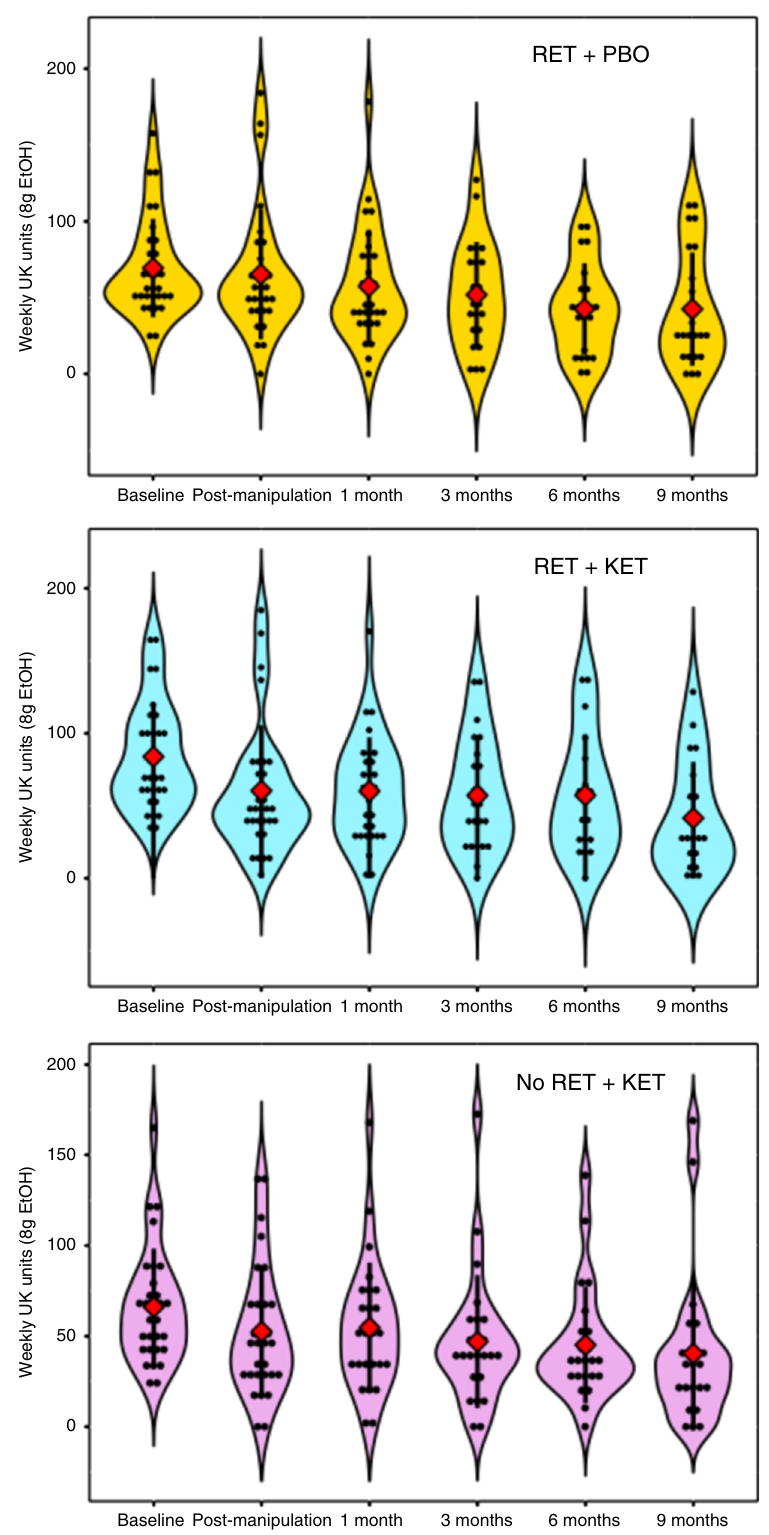
Fig. 3 Individual-level total unit drinking data across all time-points. Top Panel = RET + PBO, Middle Panel = RET + KET, Bottom panel = No RET + KET. Dots represent individual data points and the “ violins ” the relative kernel density across the entire range of values. Diamonds and whiskers represent mean ± SD of each time point. Source data are provided as a Source Data fi